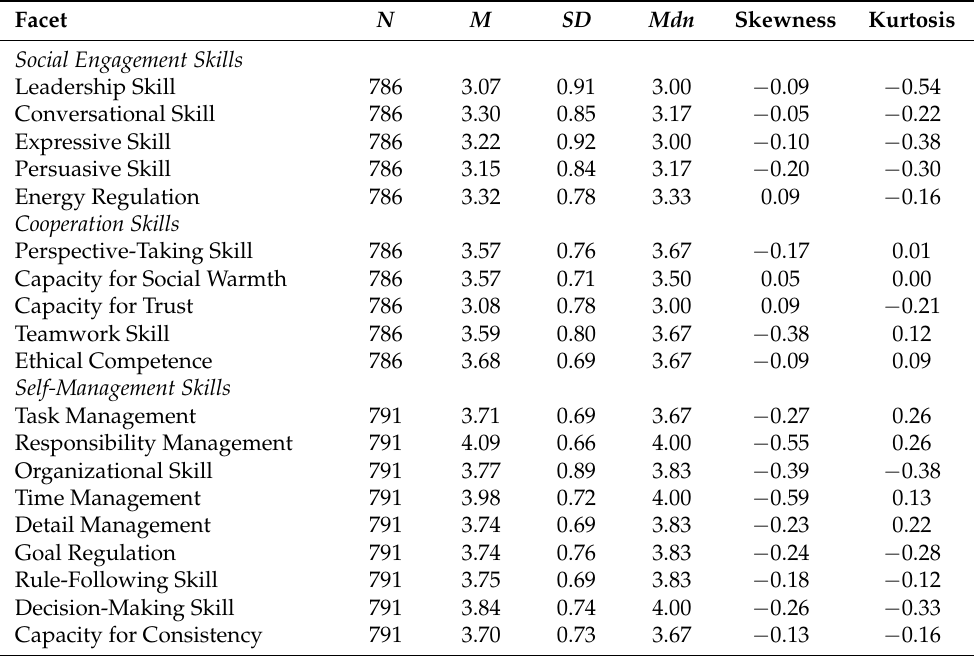
Table A5. Descriptive statistics for the observed facet scores (Study